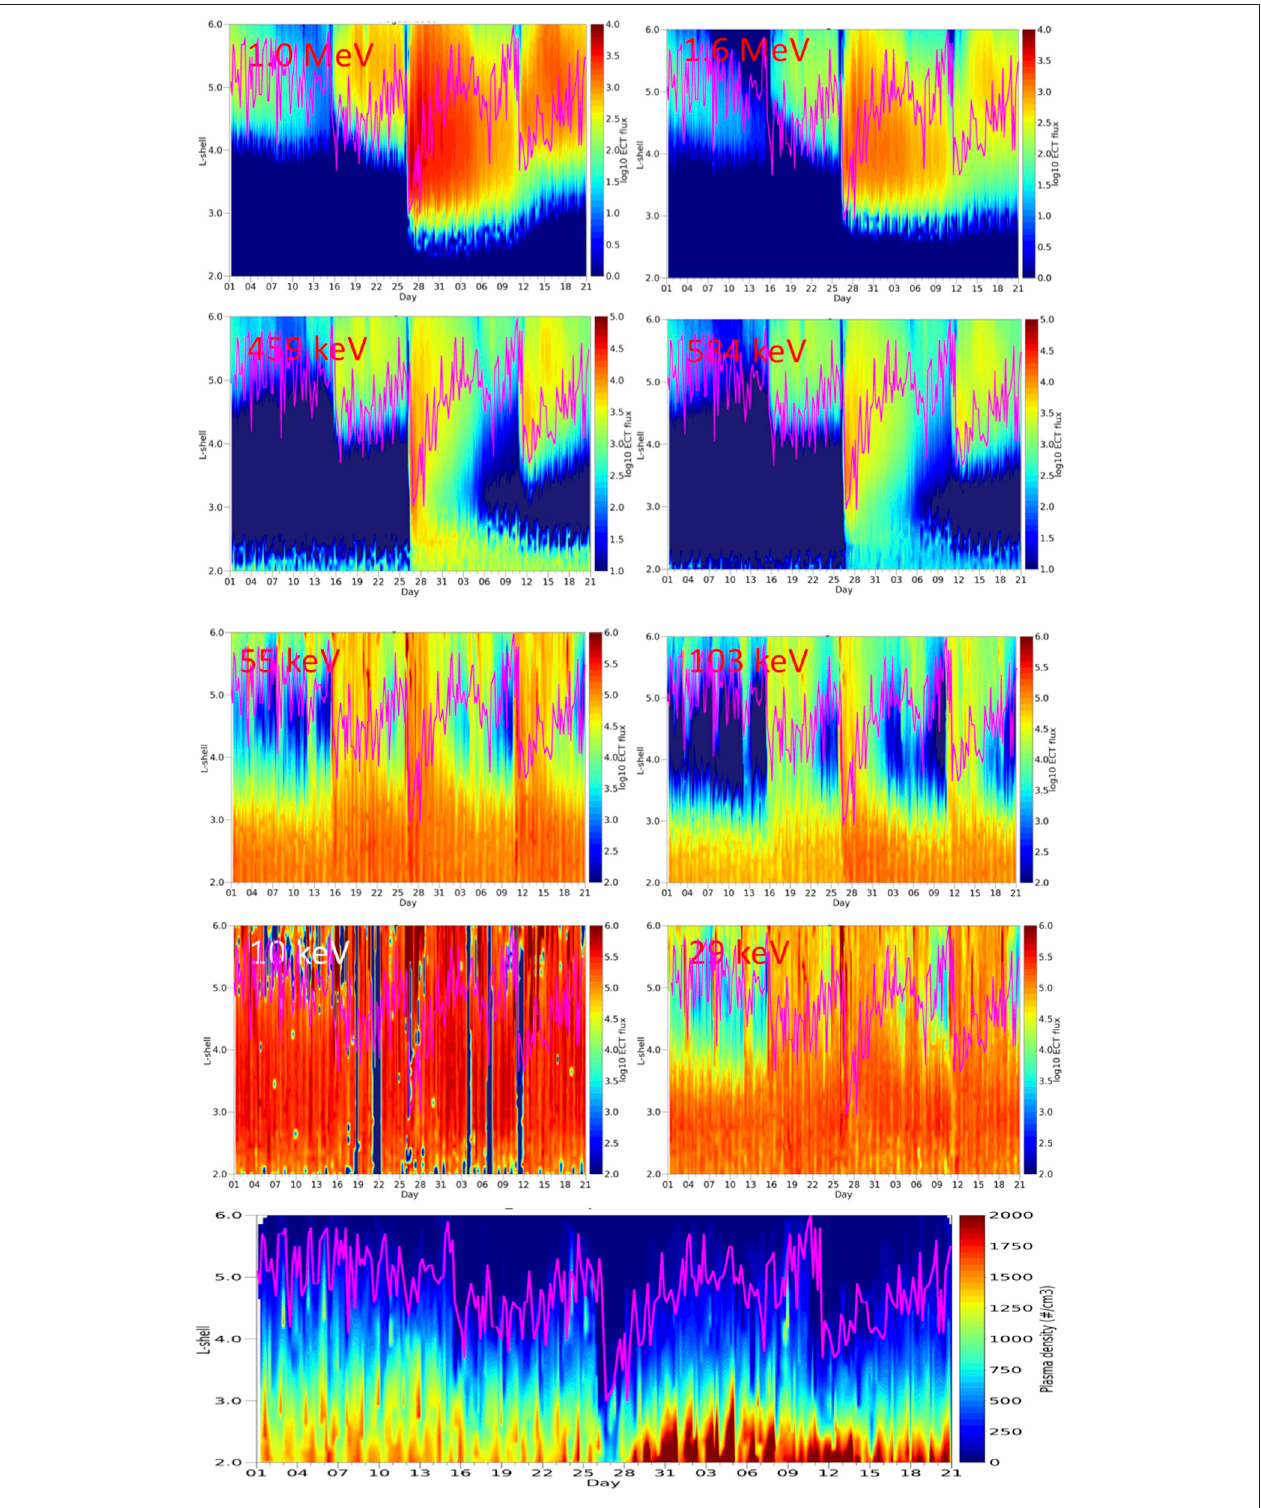
FIGURE 13 | Level 2 ECT combined radiation belt spin-averaged fl ux plotted versus time and L-shell from 1 August to September 20, 2018 measured by the ECT suite of Van Allen Probes in the magnetic equatorial plane. The magenta line corresponds to the plasmapause position measured by EMFISIS on RBSP B. (Top 4) sub-relativistic andrelativisticelectrons. (Next4) lowenergyseedelectrons (10 – 100 keV). (Bottompanel) Plasma densityofRBSPB/EMFISIScomputed asexplained in section Van Allen Probes Plasmapause Observations , from 1 August to September 21, 2018.